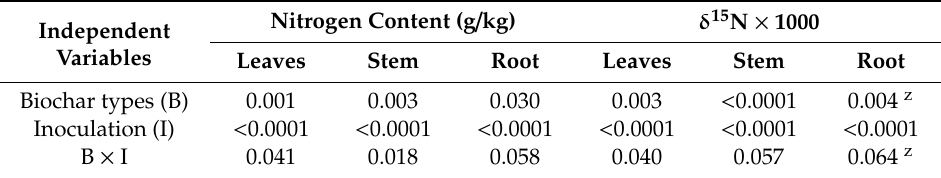
Table 3. p -Values for final black locust seedling nitrogen content and δ 15 N × 1000.